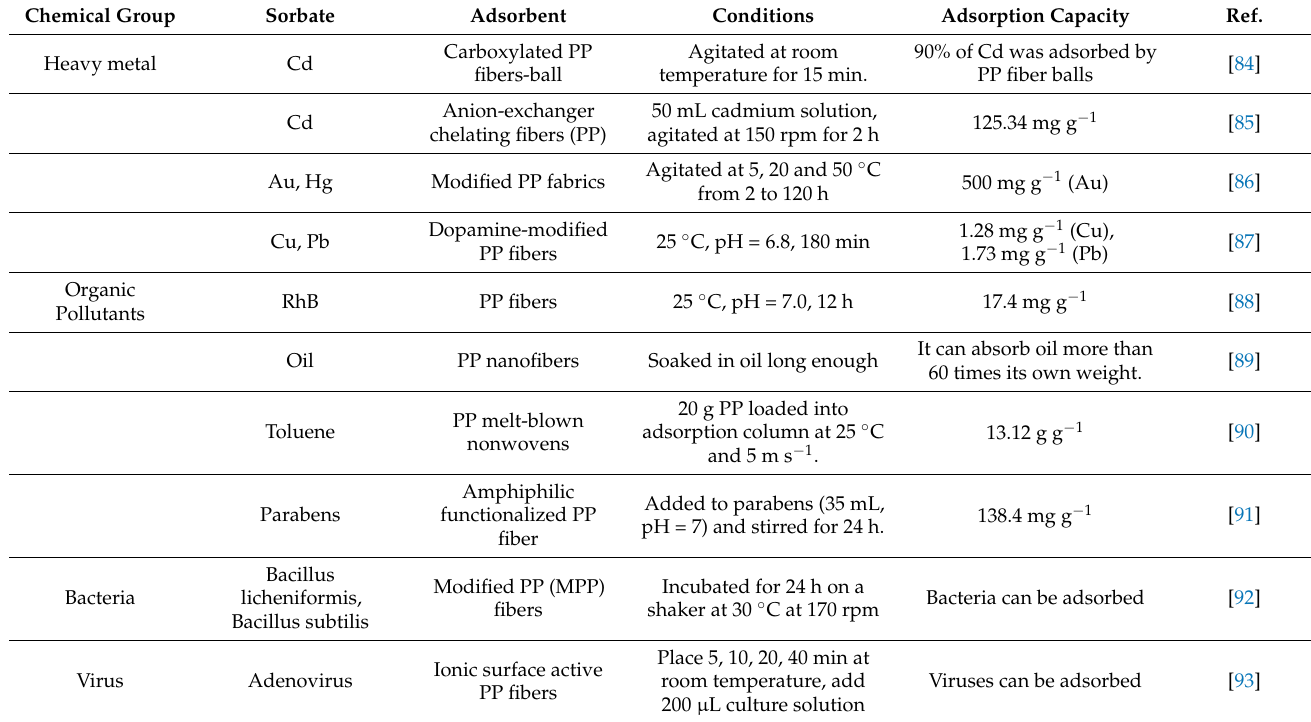
Table 3. Pollutant adsorption capacity of PP